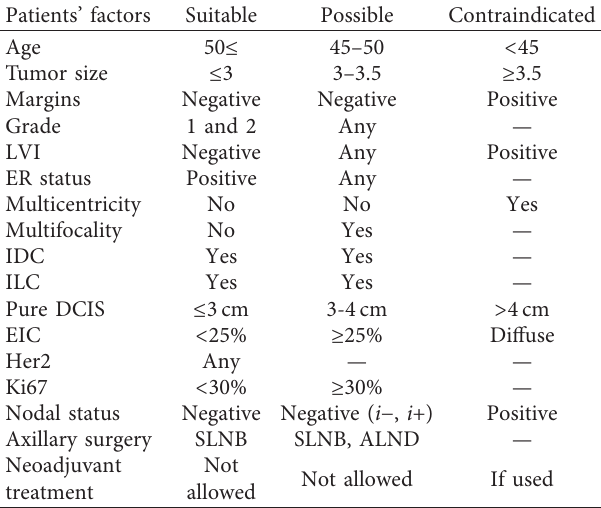
Table 1: IRIORT consensus protocol for radical